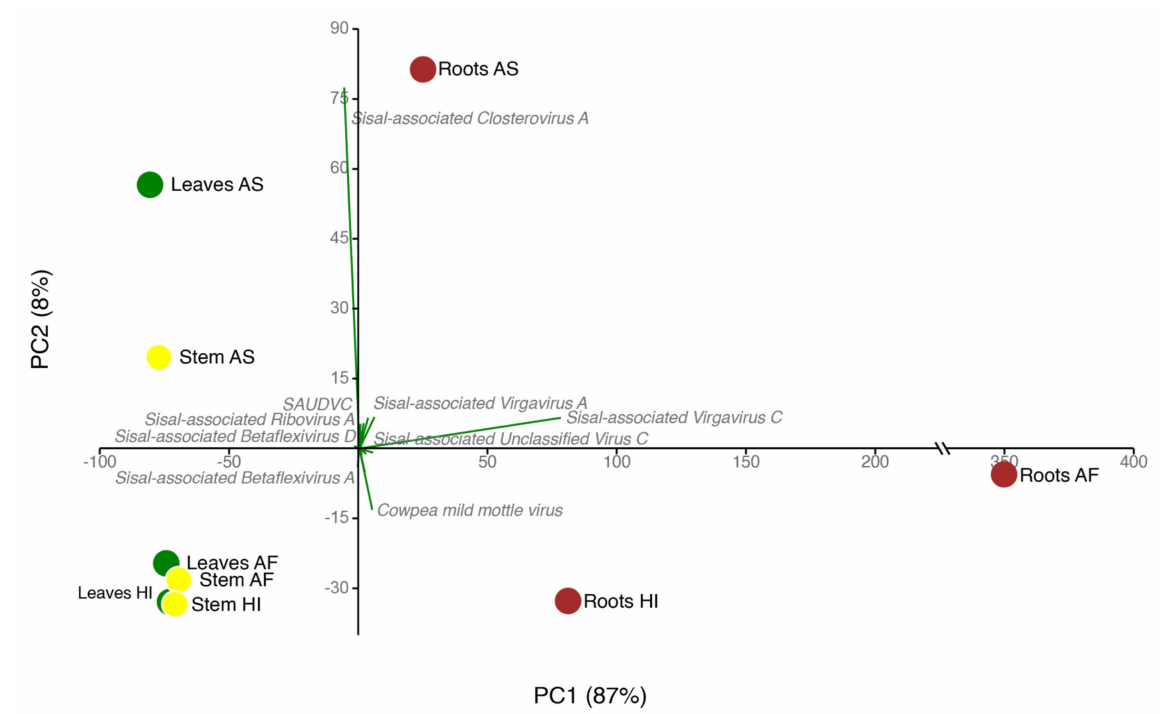
Figure 4. Principal component analysis of virus abundance in Agave organs. Viral species were used according to their abundance (green arrows) and presence in organs; Each organ (dots) is represented by a color: leaves (green dots), stems (yellow dots), and roots (brown